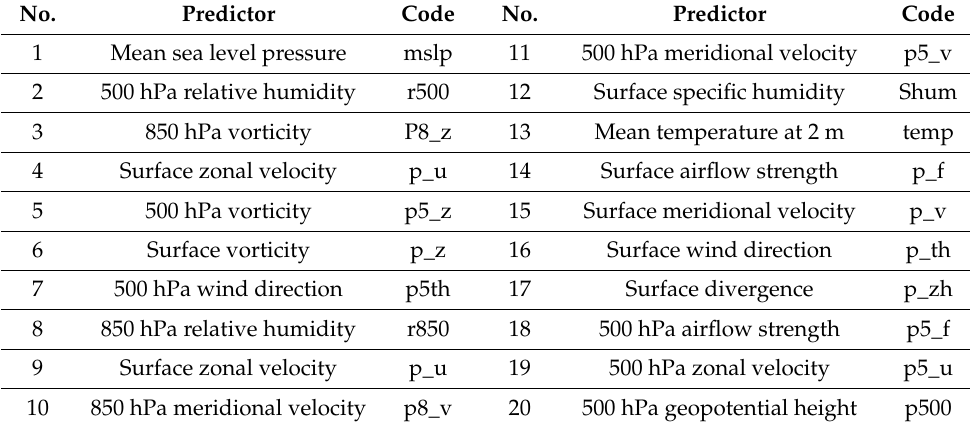
Table 3. Description of NCEP predictor.